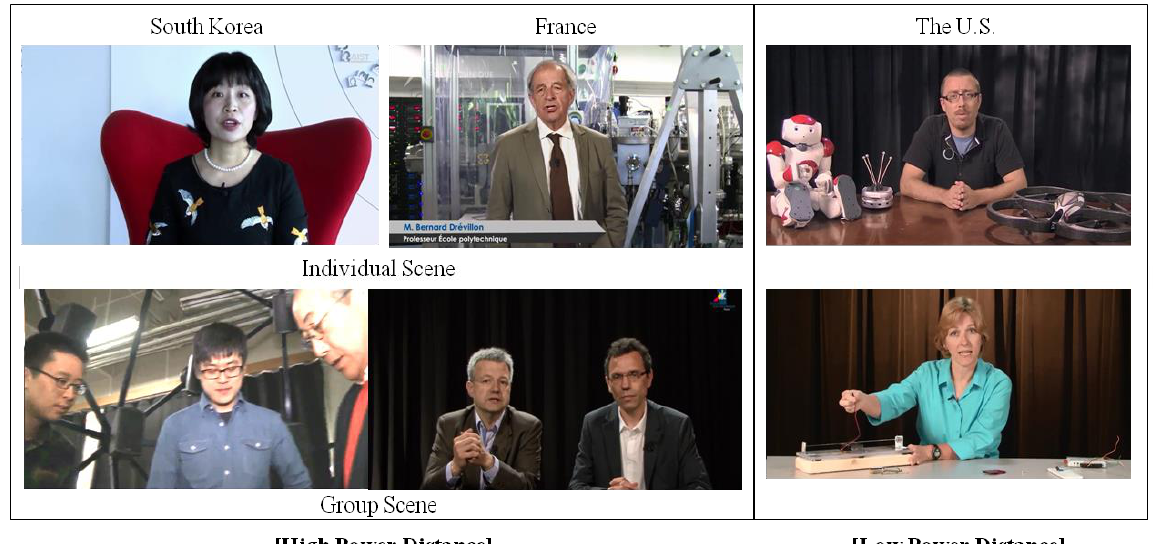
Figure 1. Example of high power distance and low power